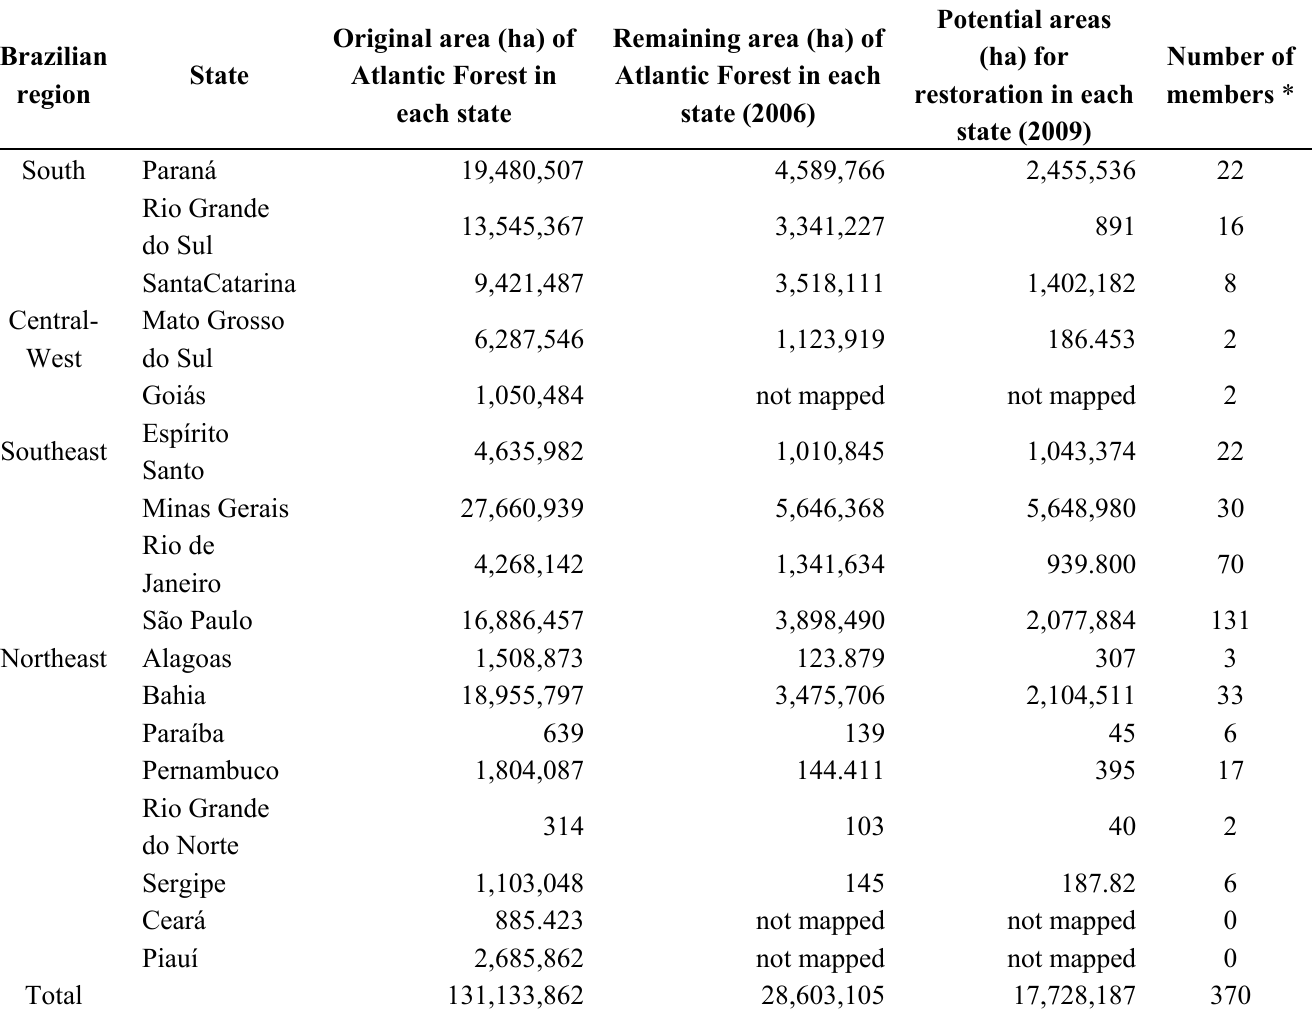
Table 1. Distribution of the original and remaining native vegetation cover in the Atlantic Forest biome, and potential areas for forest restoration mapped by the Atlantic Forest Restoration